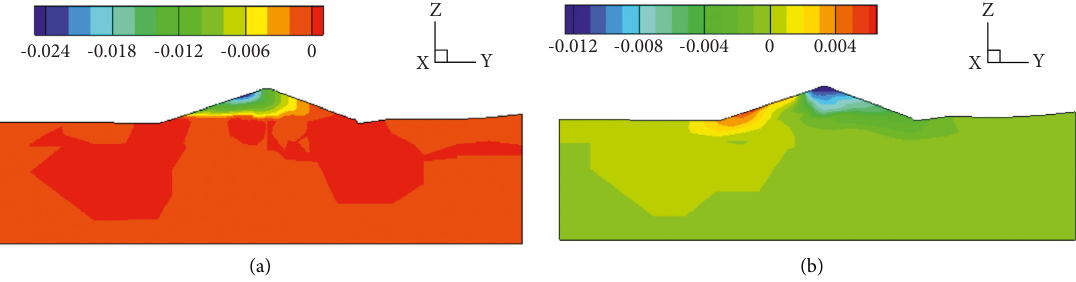
Figure 8: Deformation of dam on the 20th day after the sharp drop in the storage level (m): (a) settlement; (b) lateral